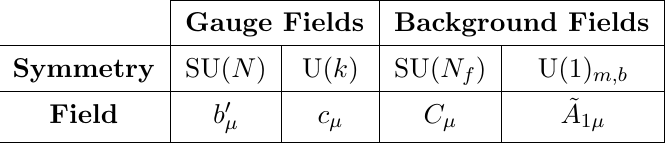
Table 1 . De(cid:12)nitions of various gauge (cid:12)elds used in the duality of